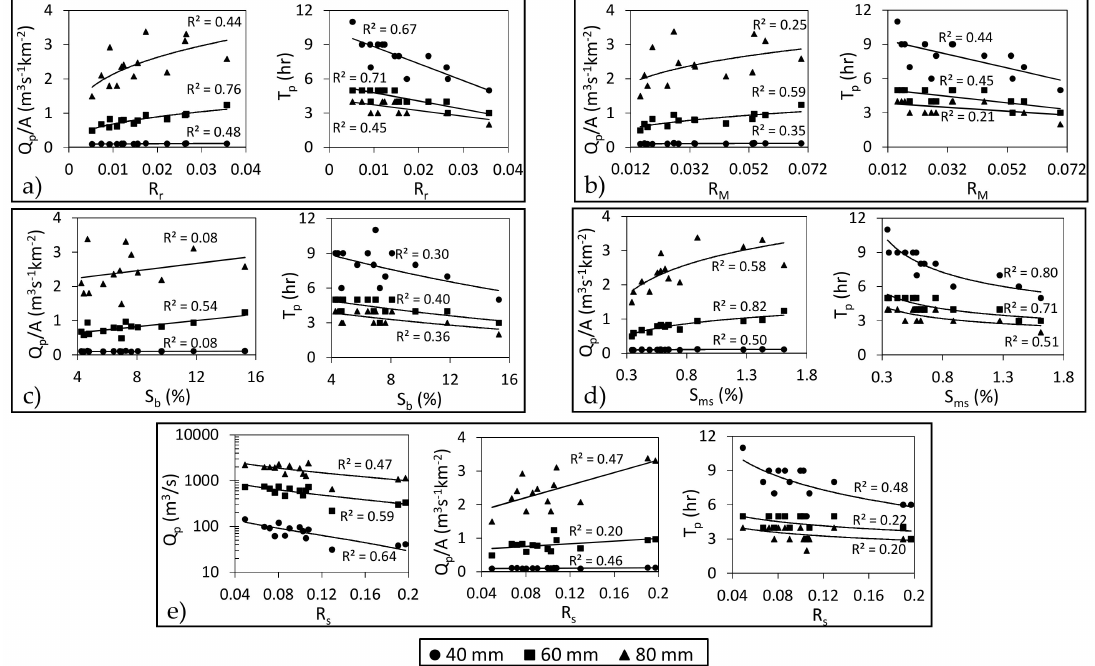
Figure 12. Relationship between the hydrological indices and significant basin topographic parameters: ( a ) Relief ratio ( R r ), ( b ) Melton relative relief ( R M ), ( c ) mean basin slope ( S b ), ( d ) mainstream slope ( S ms ) and ( e ) slope ratio ( R s ) under different storm